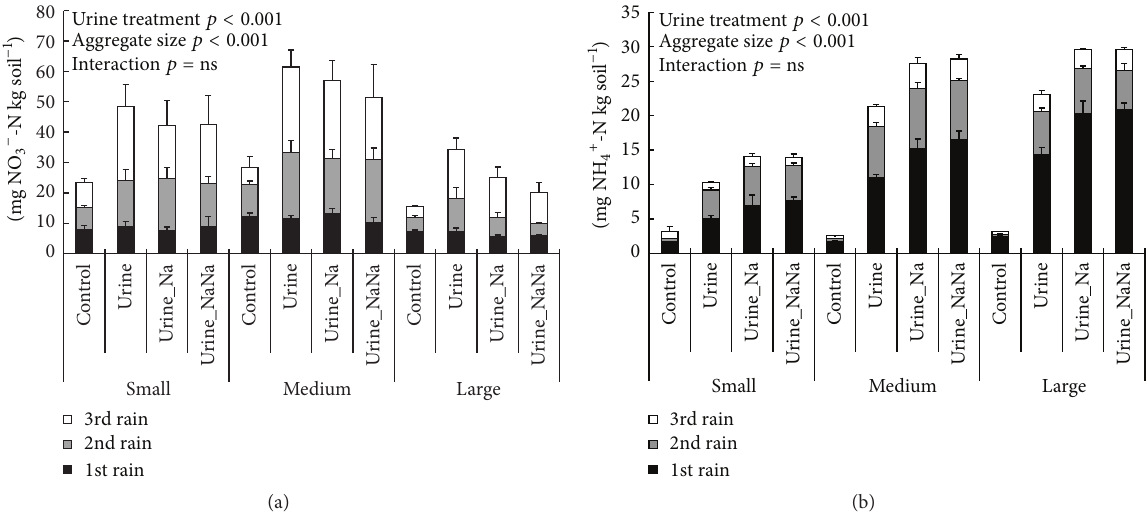
Figure 2: The amount of nutrient loss from soil cores after simulated rain events. Different coloured bars indicate the nutrient loss after each simulated rain treatment. The loss of (a) NO 3− -N and (b) NH 4+ -N was shown in separate figures. The error bars indicate standard deviations ( 𝑛 = 3